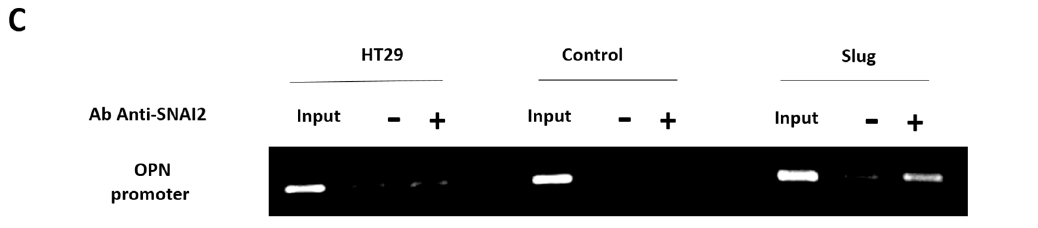
Figure 5. Slug/SNAI2 binds directly to the OPN promoter and enhances its transcriptional activity. ( A ) Luciferase activity in HT-29 control cells (black) and in Slug-transfected HT-29 cells (gray) of the proximal ( − 213/+87) and the distal ( − 1206/+87) OPN promoter. The fold induction was calculated after normalization with empty vector. Cells were co-transfected with RSV- β -galactosidase to normalize the luciferase activity. The graphs represent the mean of 3 independent experiments. Bars, SEM. Data were considered significant if p was less than 0.05 as determined by the two-tailed Student’s t -test. Symbols: ** p < 0.01, NS, not significant. ( B ) The proximal promoter region of OPN by BLAST, indicating the putative Slug binding sites (e-box) and the primers (red arrows) that were used. ( C ) Chromatin immunoprecipitation (ChIP) analysis with a Slug-directed antibody in parental, control, and Slug-transfected cells.